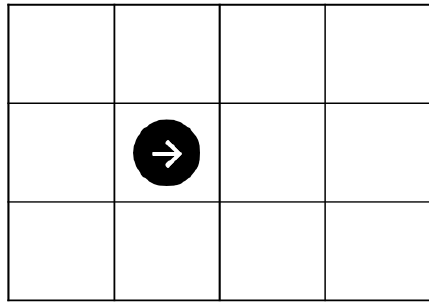
Figure 2. Sight of agent when facing